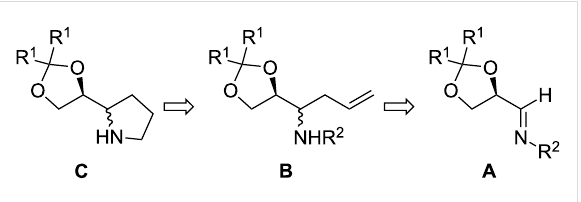
Figure 1: Strategy for the preparation of 2-substituted pyrrolidines C